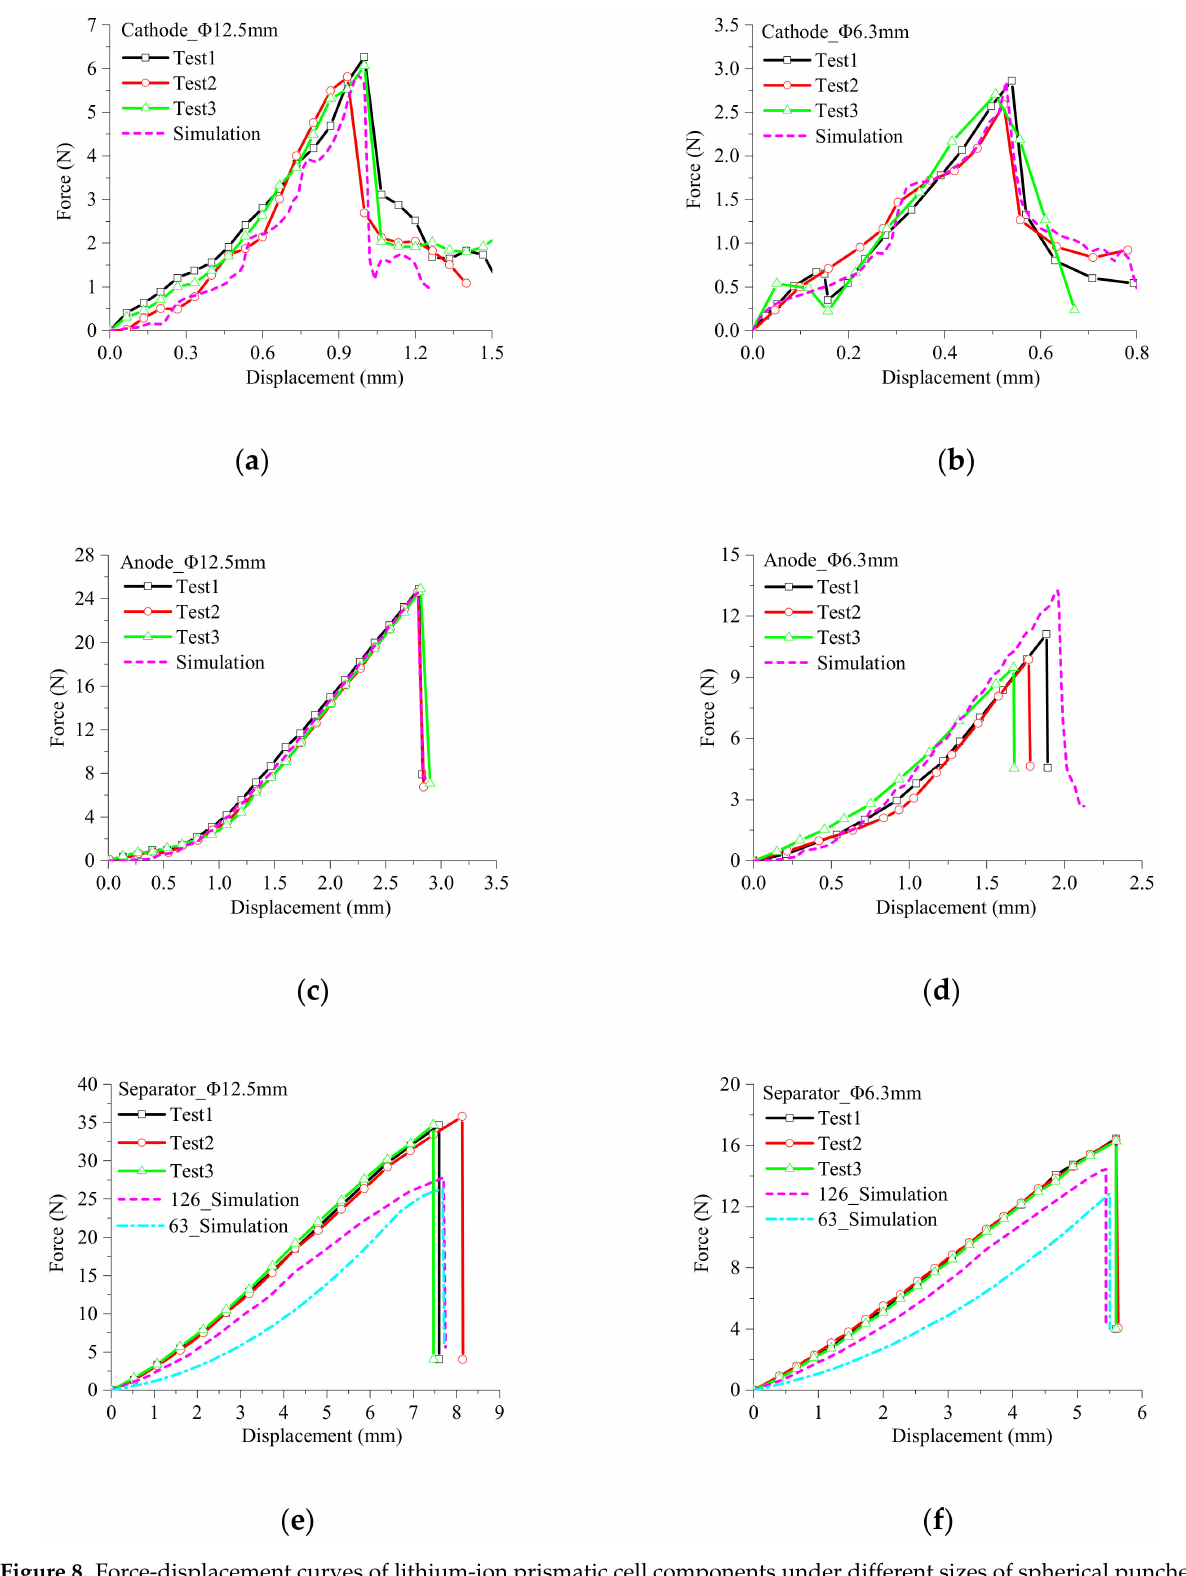
Figure 8. Force-displacement curves of lithium-ion prismatic cell components under different sizes of spherical punches: ( a ) Cathode tests and simulation under Φ 12.5 mm; ( b ) Cathode tests and simulation under Φ 6.3 mm; ( c ) Anode tests and simulation under Φ 12.5 mm; ( d ) Anode tests and simulation under Φ 6.3 mm; ( e ) Separator tests and simulation under Φ 12.5 mm; ( f ) Separator tests and simulation under Φ 6.3